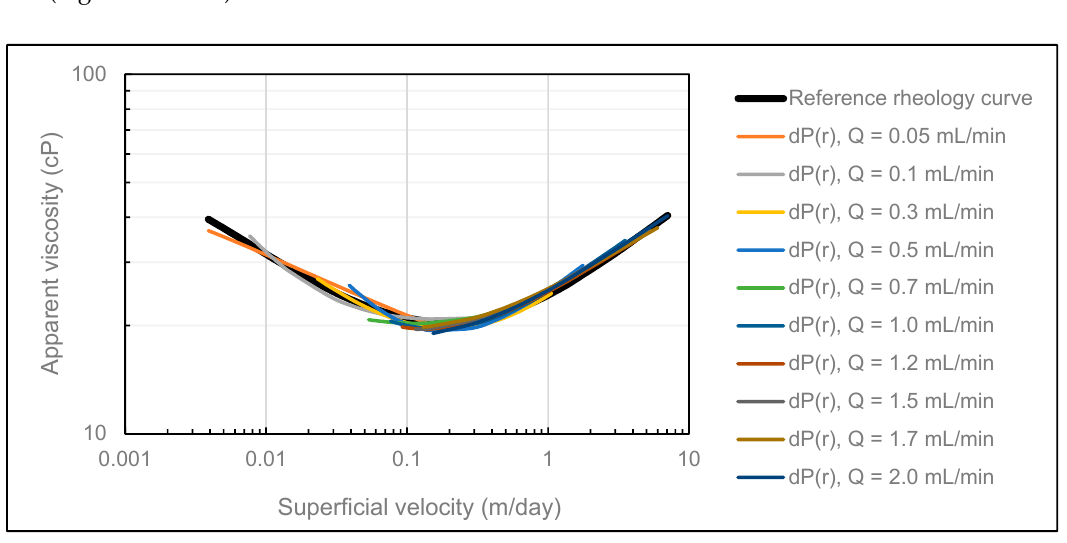
8 of 13 Figure 4. Comparison of the reference rheology curve (black) and rheology curves obtained in CMOST when the reference dataset was history matched using the SPMM. To investigate the robustness of both history match methods, pressure measurement errors typical for in-house radial flow experiments were randomly added or subtracted from the reference